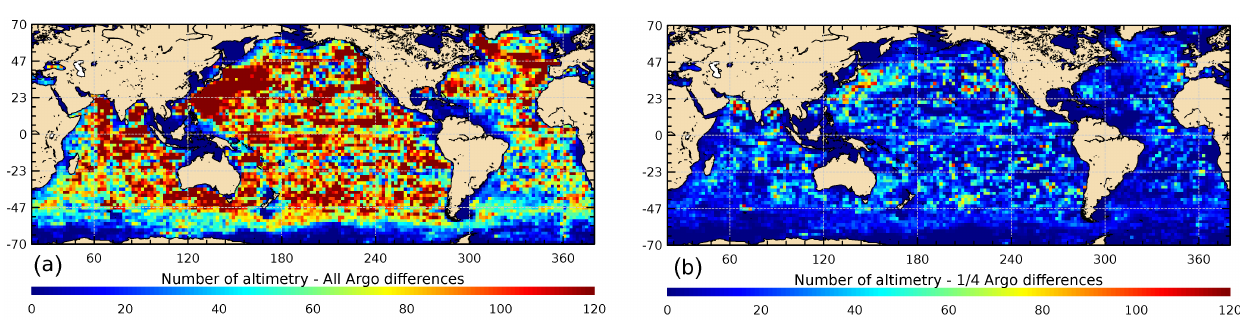
Figure 9. Number of Argo profiles per 2 ◦ × 2 ◦ boxes over 2005–2012 from all Argo floats (a) and from 25% of the floats (b)